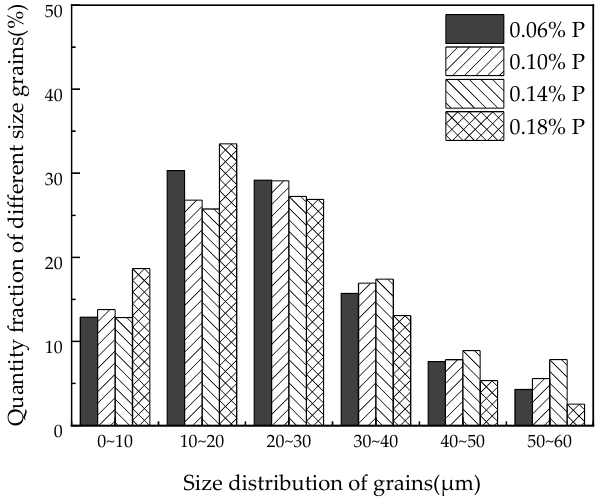
Figure 4. Quantity fraction of different sizes of precipitates in the different P-targeted samples. Based on the composition of the experimental samples and the solubility products of MnS, AlN, and Si 3 N 4 in the ferritic steel in Table 2, the theoretical solid solution or precip- itation temperature of MnS, AlN, and Si 3 N 4 in solid steel are 1493 K, 1438 K, and 1105 K, respectively. There were some precipitate solution, precipitation, and growth during re- heating, rolling, and the cold-rolled plate continuous annealing process. In particular, un- stable Si 3 N 4 in fine-sized (Al,Si) x N y or (Al,Si,Mn) x N y will solubilize or precipitate at 1105